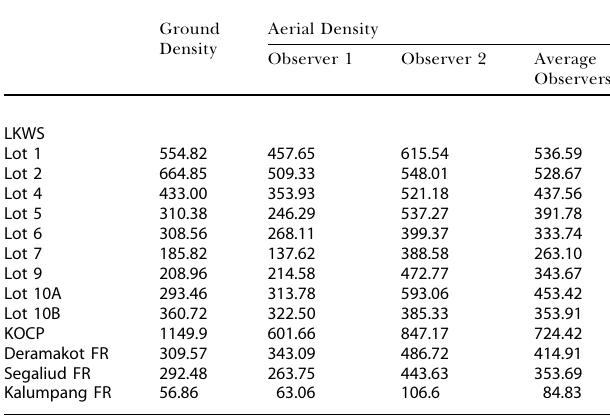
Table 1. Estimated Ground and Aerial Orangutan Nest Densities (Number of Nests/ km 2 ) at 13 Different Sites Surveyed during the Orangutan General Census of Sabah Ground